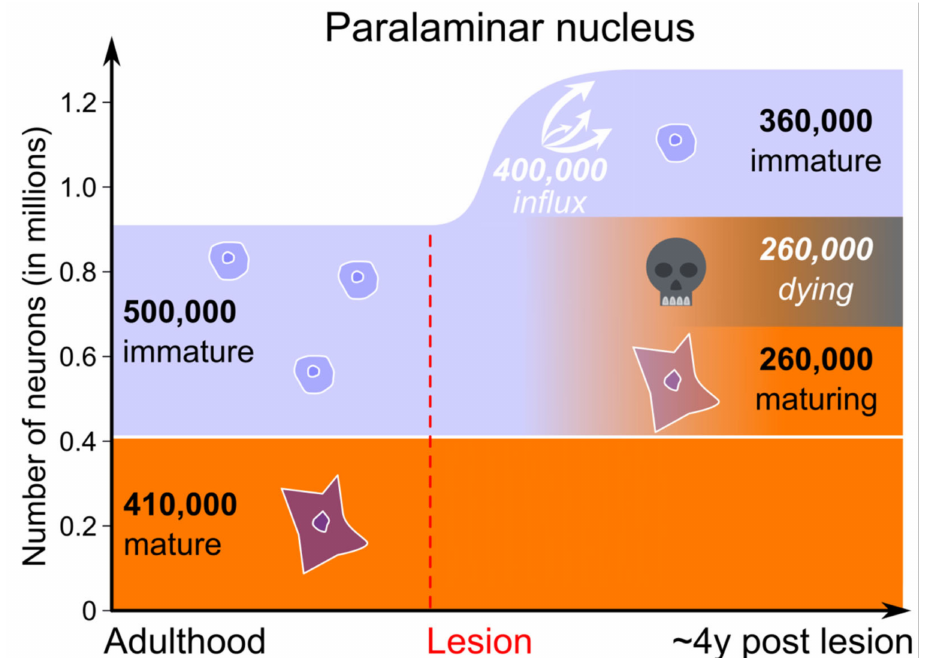
Figure 6. Proposed sequence of neuron maturation in the paralaminar nucleus of the monkey amygdala following adult hippocampal lesion. Light blue: immature neuron population; orange: mature neuron population. Numbers in white italic are speculative (number of dying and migrating cells). The number of dying cells is based on the hypothesis that ~50% of neurons die in the course of maturation (see main text). All the other cell number estimates were obtained with design-based stereological techniques applied to Nissl-stained monkey brain sections (Control monkeys n = 7; Lesioned monkeys n = 6;